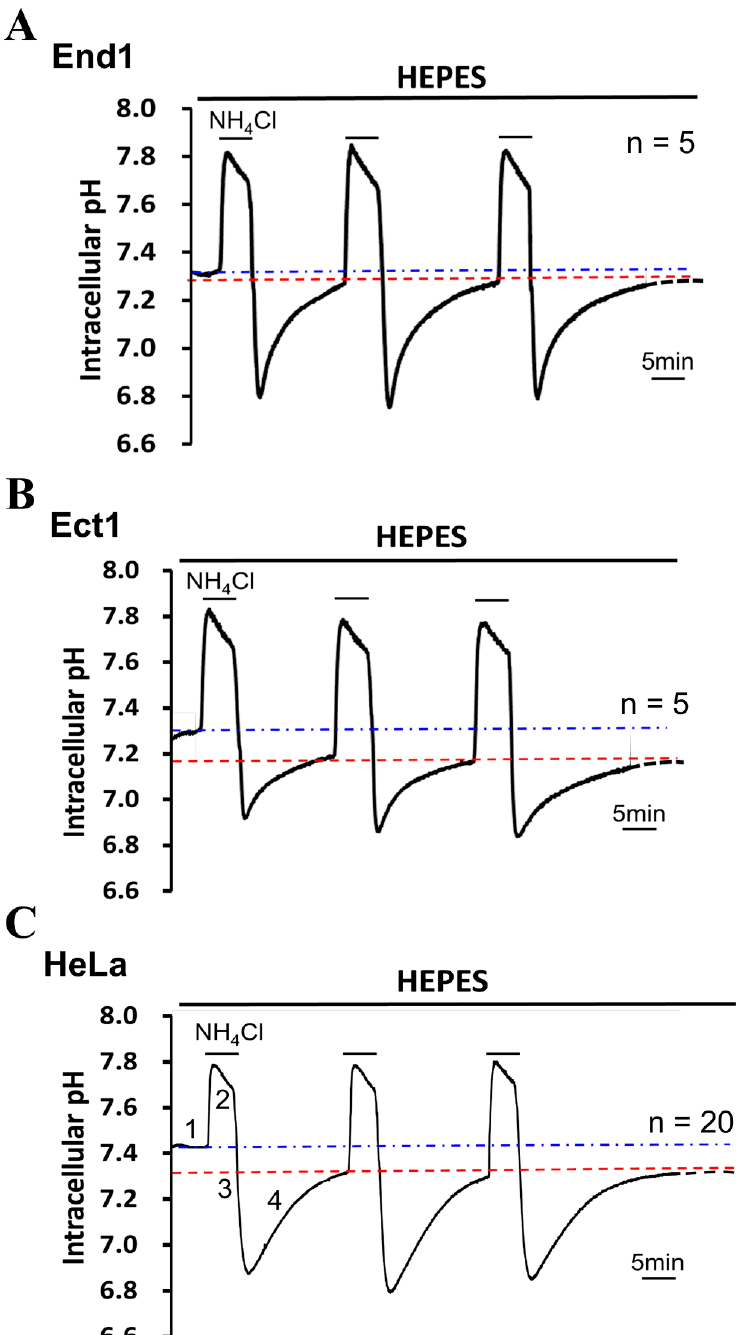
Figure 1. The resting intracellular pH (pH i ) and kinetic steady-state pH i in the endocervical cells (End1), ectocervical cells (Ect1), and human cervical cancer cells (HeLa) cells. ( A – C ) The top bars show the buffer system used in perfusion experiments. The periods of application of NH 4 Cl prepulse are shown with bars above the trace. The blue and red dotted lines represent the original and the new steady-state pH i , following NH 4 Cl prepulse induced intracellular acidification, respectively. Note that the numbers 1–4 shown in the farthest left trace of represented the typical four phases of NH 4 Cl prepulse (see more details in Section 4). The trace A – C represented the typical trace derived in experiments on End1 cells, Ect1 cells, and HeLa cells, respectively.